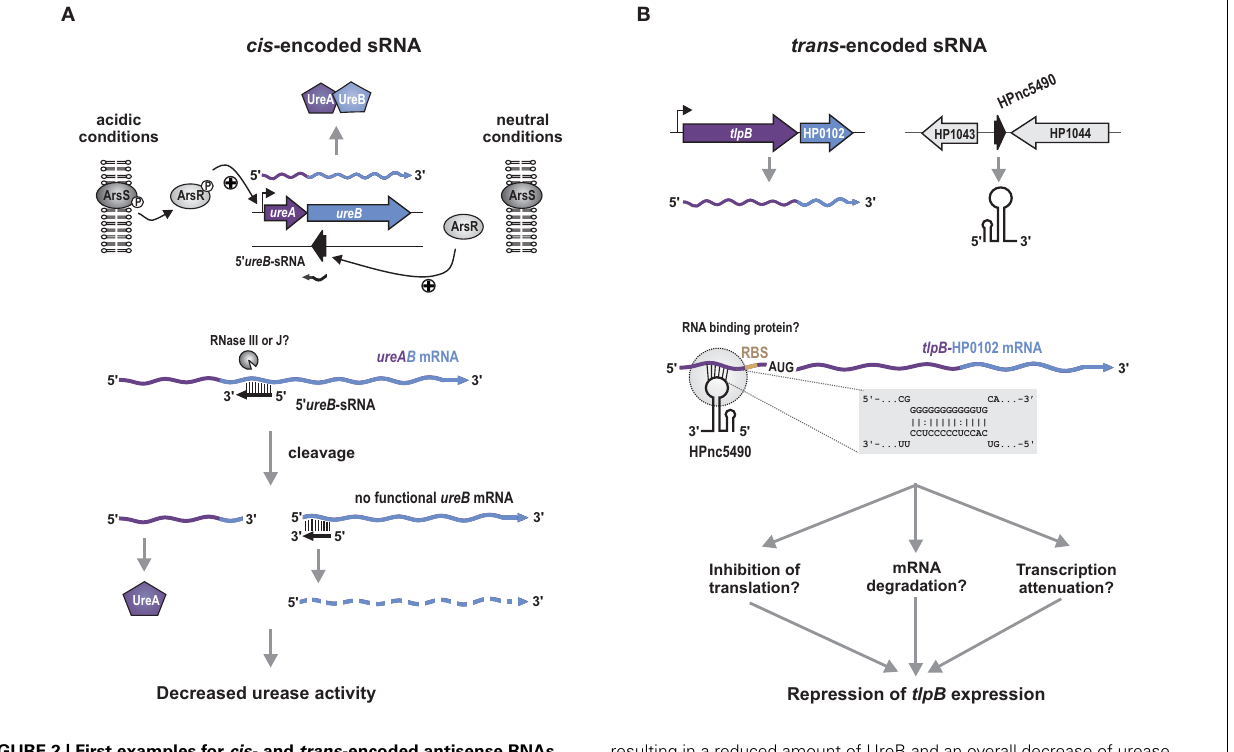
FIGURE 2 | First examples for cis - and trans -encoded antisense RNAs in H. pylori . (A) Regulation of urease by the cis- encoded antisense 5 (cid:2) ureB –sRNA. Expression of the ureAB operon, which encodes for the urease apo-enzyme, is induced under acidic conditions by the phosphorylated ArsR response regulator of the acid-responsive ArsRS two-component-system. In contrast, expression of the cis -encoded antisense transcript, 5 (cid:2) ureB –sRNA, is induced by unphosphorylated ArsR under neutral conditions. An interaction between 5 (cid:2) ureB –sRNA and the 5 (cid:2) region of ureB leads to cleavage of ureAB mRNA, possible mediated by RNase III or RNase J.Truncation of ureB mRNA prevents its